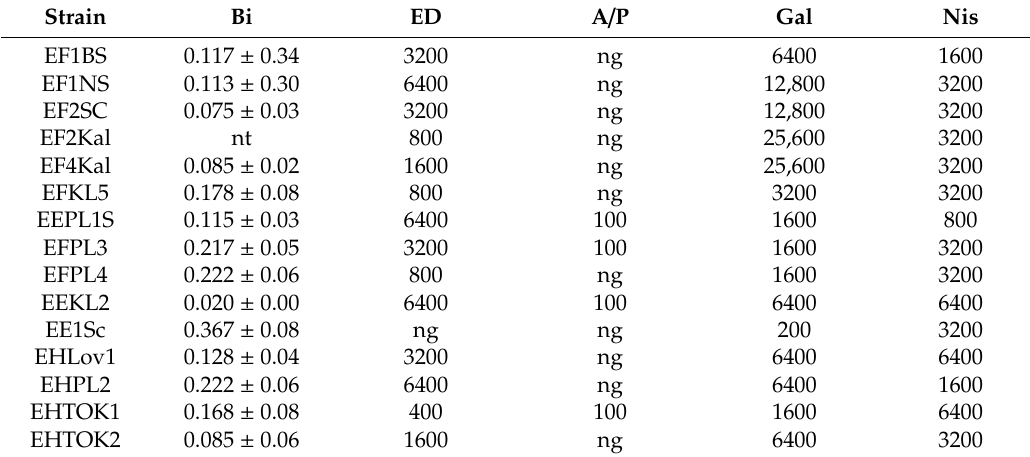
Table 3. Biofilm formation ability and susceptibility to enterocins and lantibiotic bacteriocins expressed in AU /